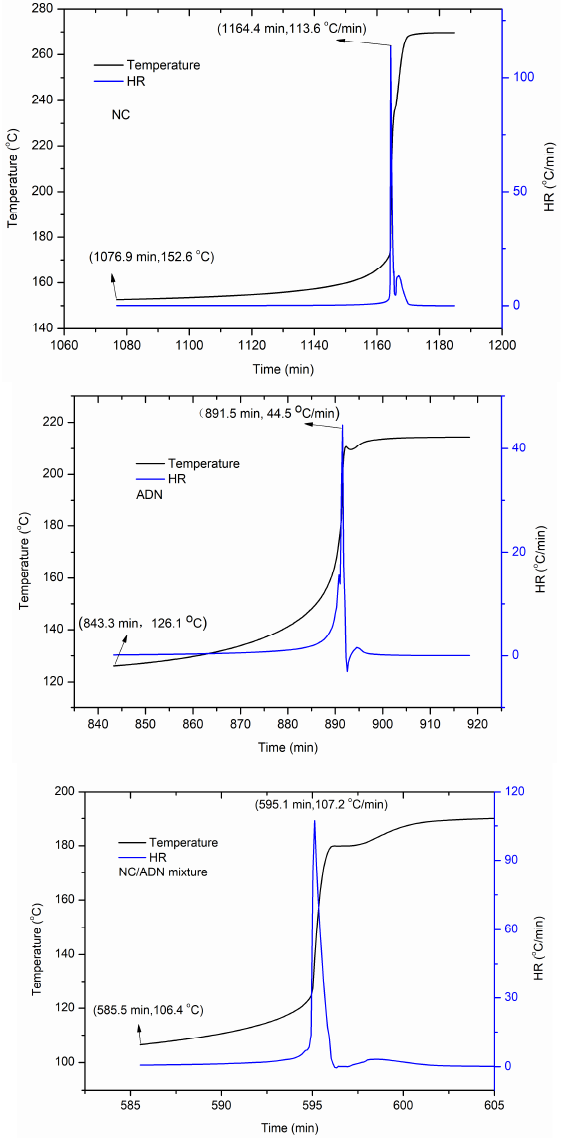
Figure 3. Thermal decomposition curves of ADN, NC and NC/ADN mixture under quasi-adiabatic circumstances. Table 2. The characteristic temperature and time of ADN, NC, NC/ADN mixture under quasi- adiabatic